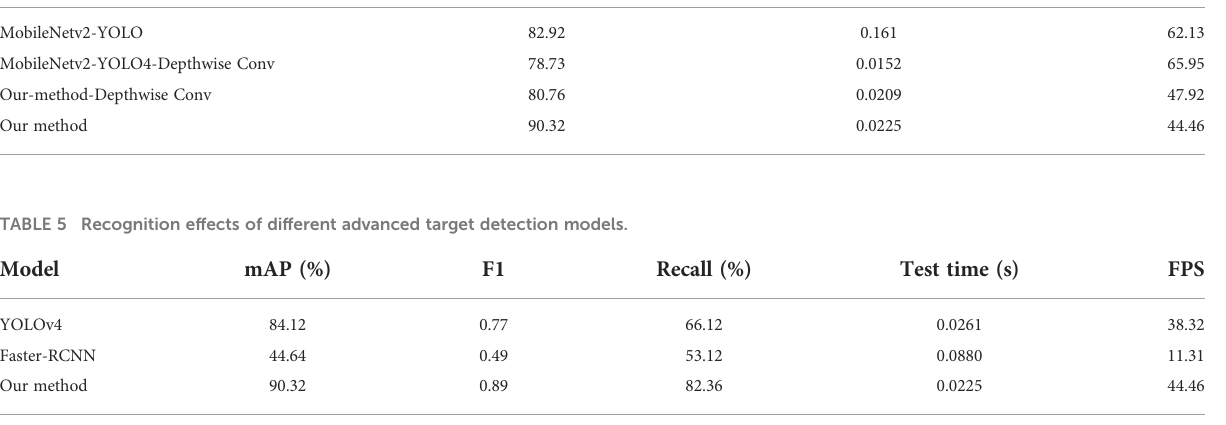
TABLE 4 Experimental results of rice panicle recognition with different target detection models. Model